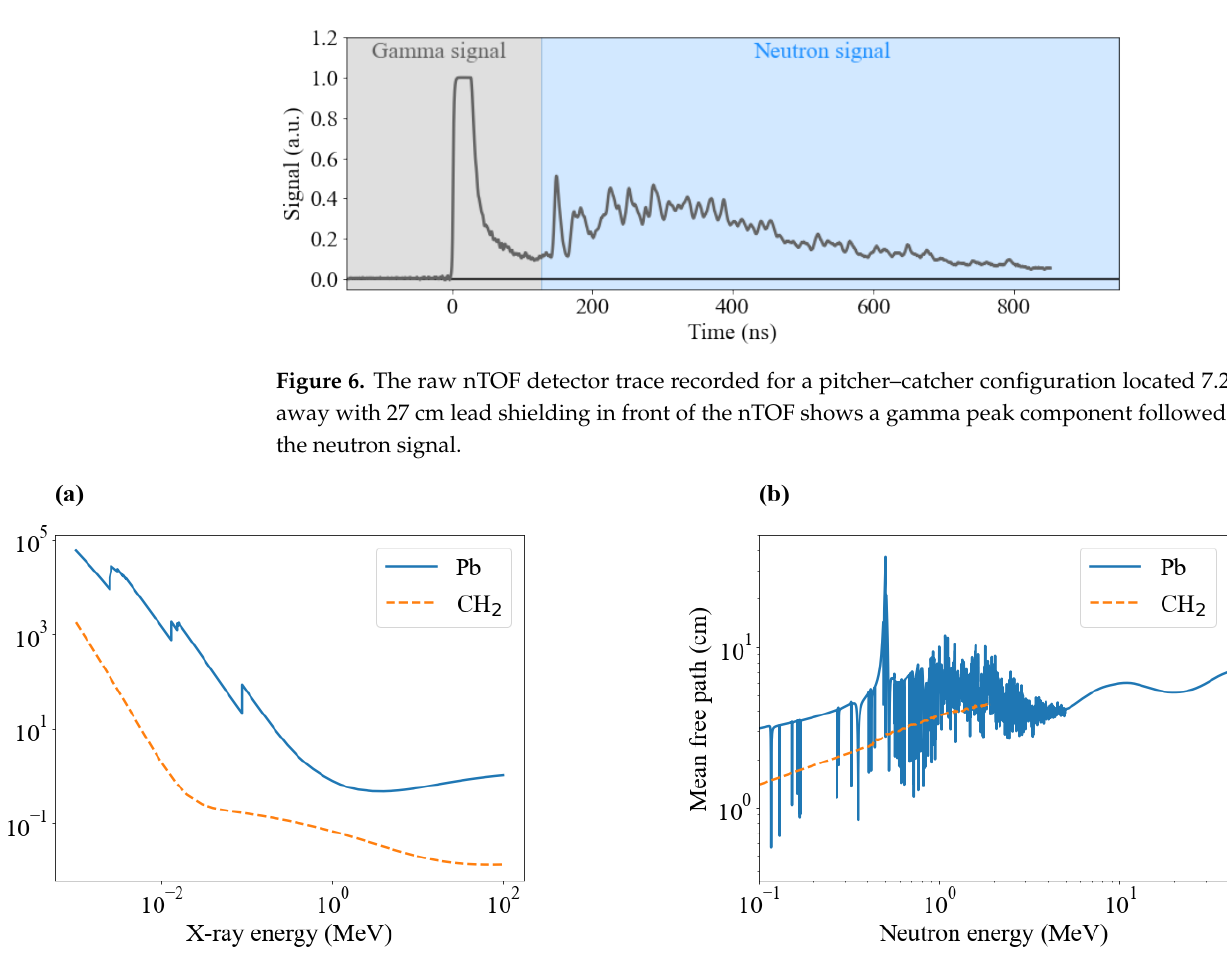
Figure 7. ( a ): X-ray attenuation coefficient (1/cm) shows superior x-ray attenuation up to three orders of magnitude in lead (Pb) over polyethylene (CH 2 ) [104]; ( b ): Neutron mean free path in lead and polyethylene